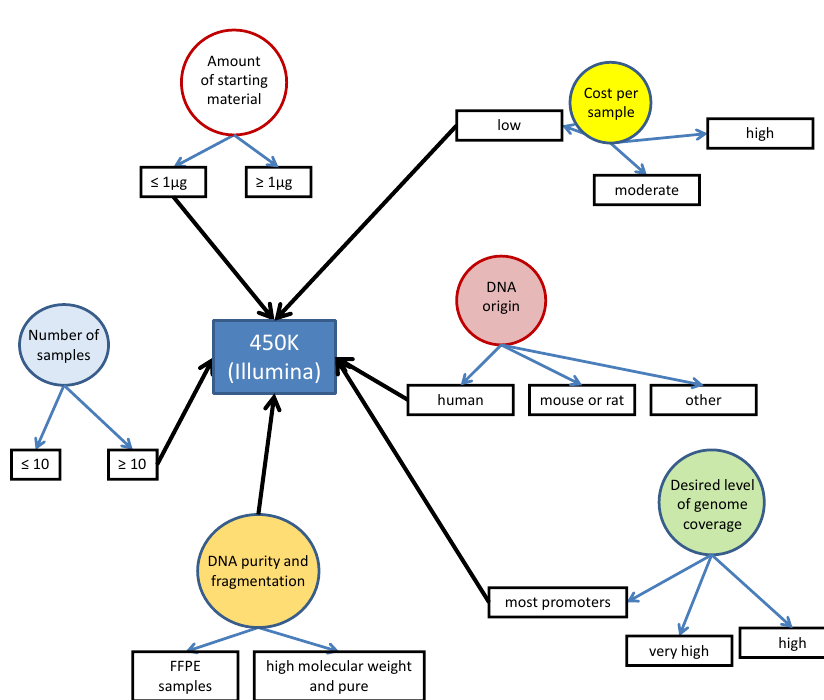
Figure 2. An example of how the algorithm can be applied.